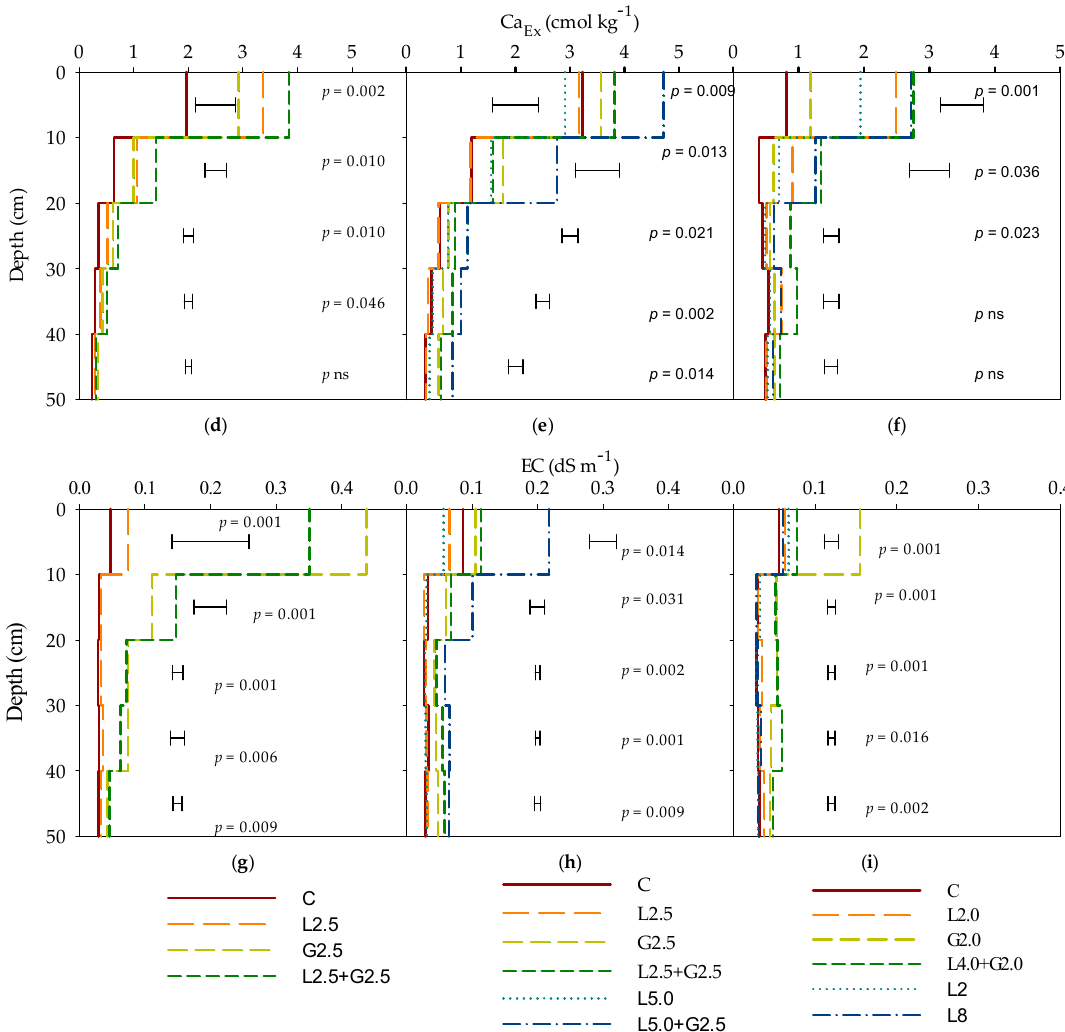
Figure 1. ( a – c ) Soil S KCl40, ( d – f ), Ca Ex , and ( g – i ) EC ( a , d , g ) in the ST for C, L2.5, G2.5, L2.5 + G2.5 treatments ( b , e , h ), in the MT for C, L2.5, G2.5, L2.5 + G2.5, L5.0, and L5.0 + G2.5 treatments and; ( c , f , i ) in the LT for C, L4, G2, L4 + G2, L2, and L8 treatments. Error bars represent least significant difference values at p = 0.05, n = 3 for each depth with ns denoting p > 0.05.